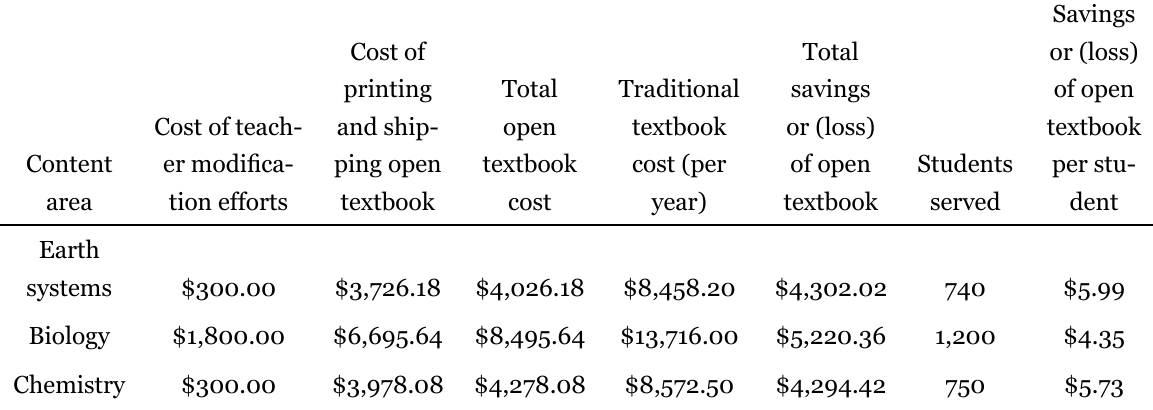
Summary of Cost Data for Open and Traditional Textbooks